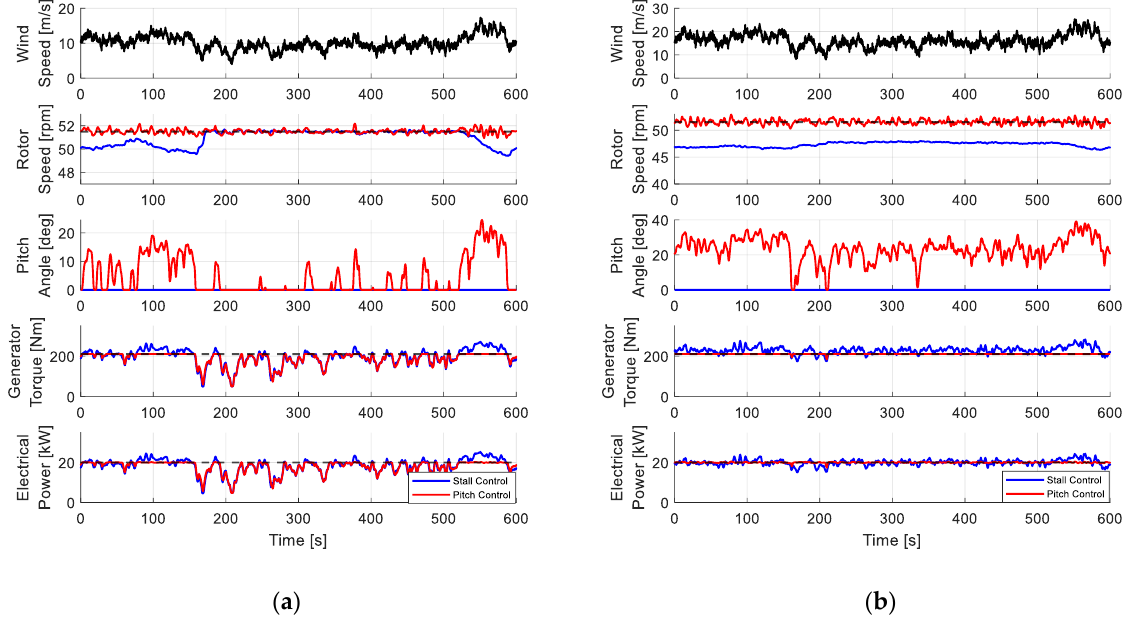
Figure 11. Dynamic simulation results of pitch control and stall control: ( a ) average wind speed of 10 m/s (mostly Region II and II-1/2); ( b ) average wind speed of 16 m/s (mostly Region